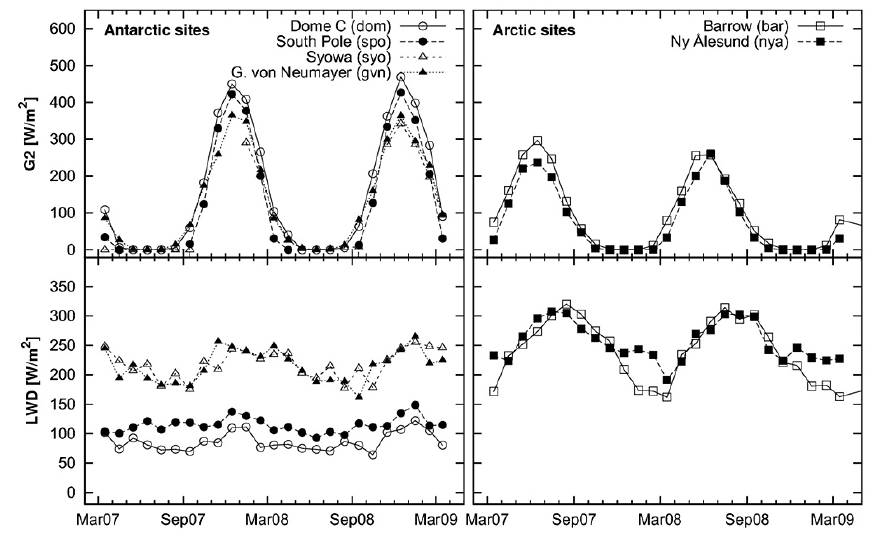
Figure 6. Monthly means of global downwelling shortwave G2, and downwelling longwave radiation LWD for the Antarctic (left) and Arctic stations (right). G1 is used to fill periods uncovered by